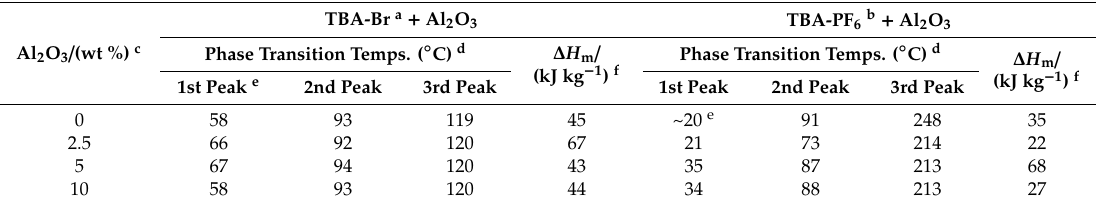
Table 1. Phase transition temperatures and melting enthalpy of TBA-Br + Al 2 O 3 additive and TBA-PF 6 + Al 2 O 3 additive from DSC thermogram.